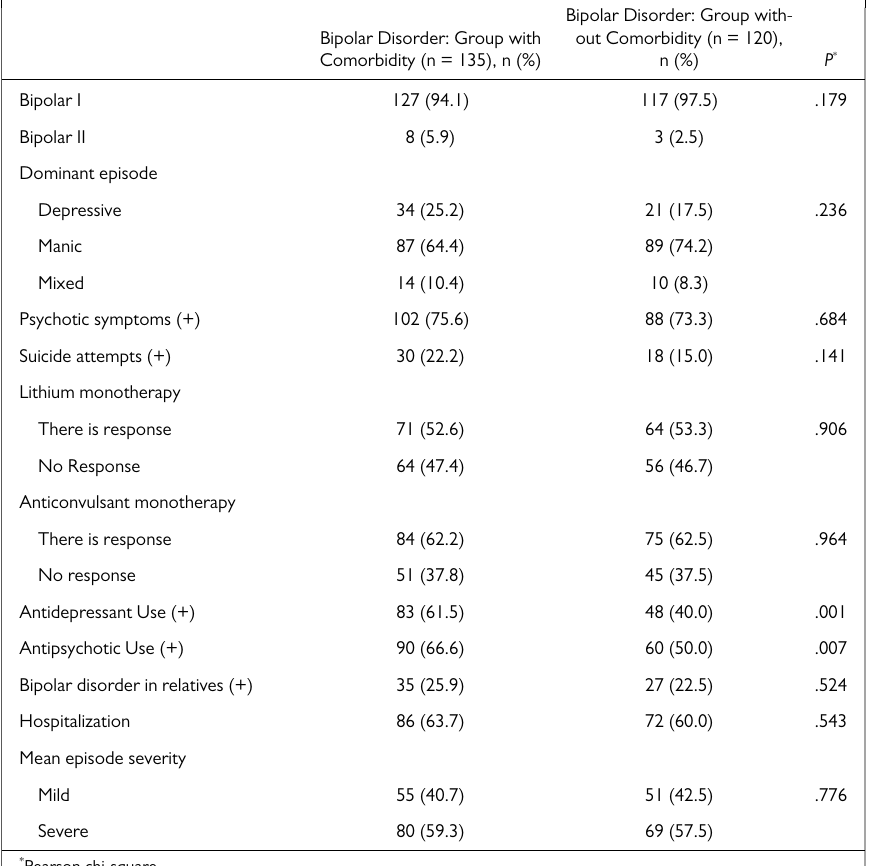
Table 1. Di ff erential Qualitative Characteristics of Bipolar Patients with and without a Comorbid Disorder